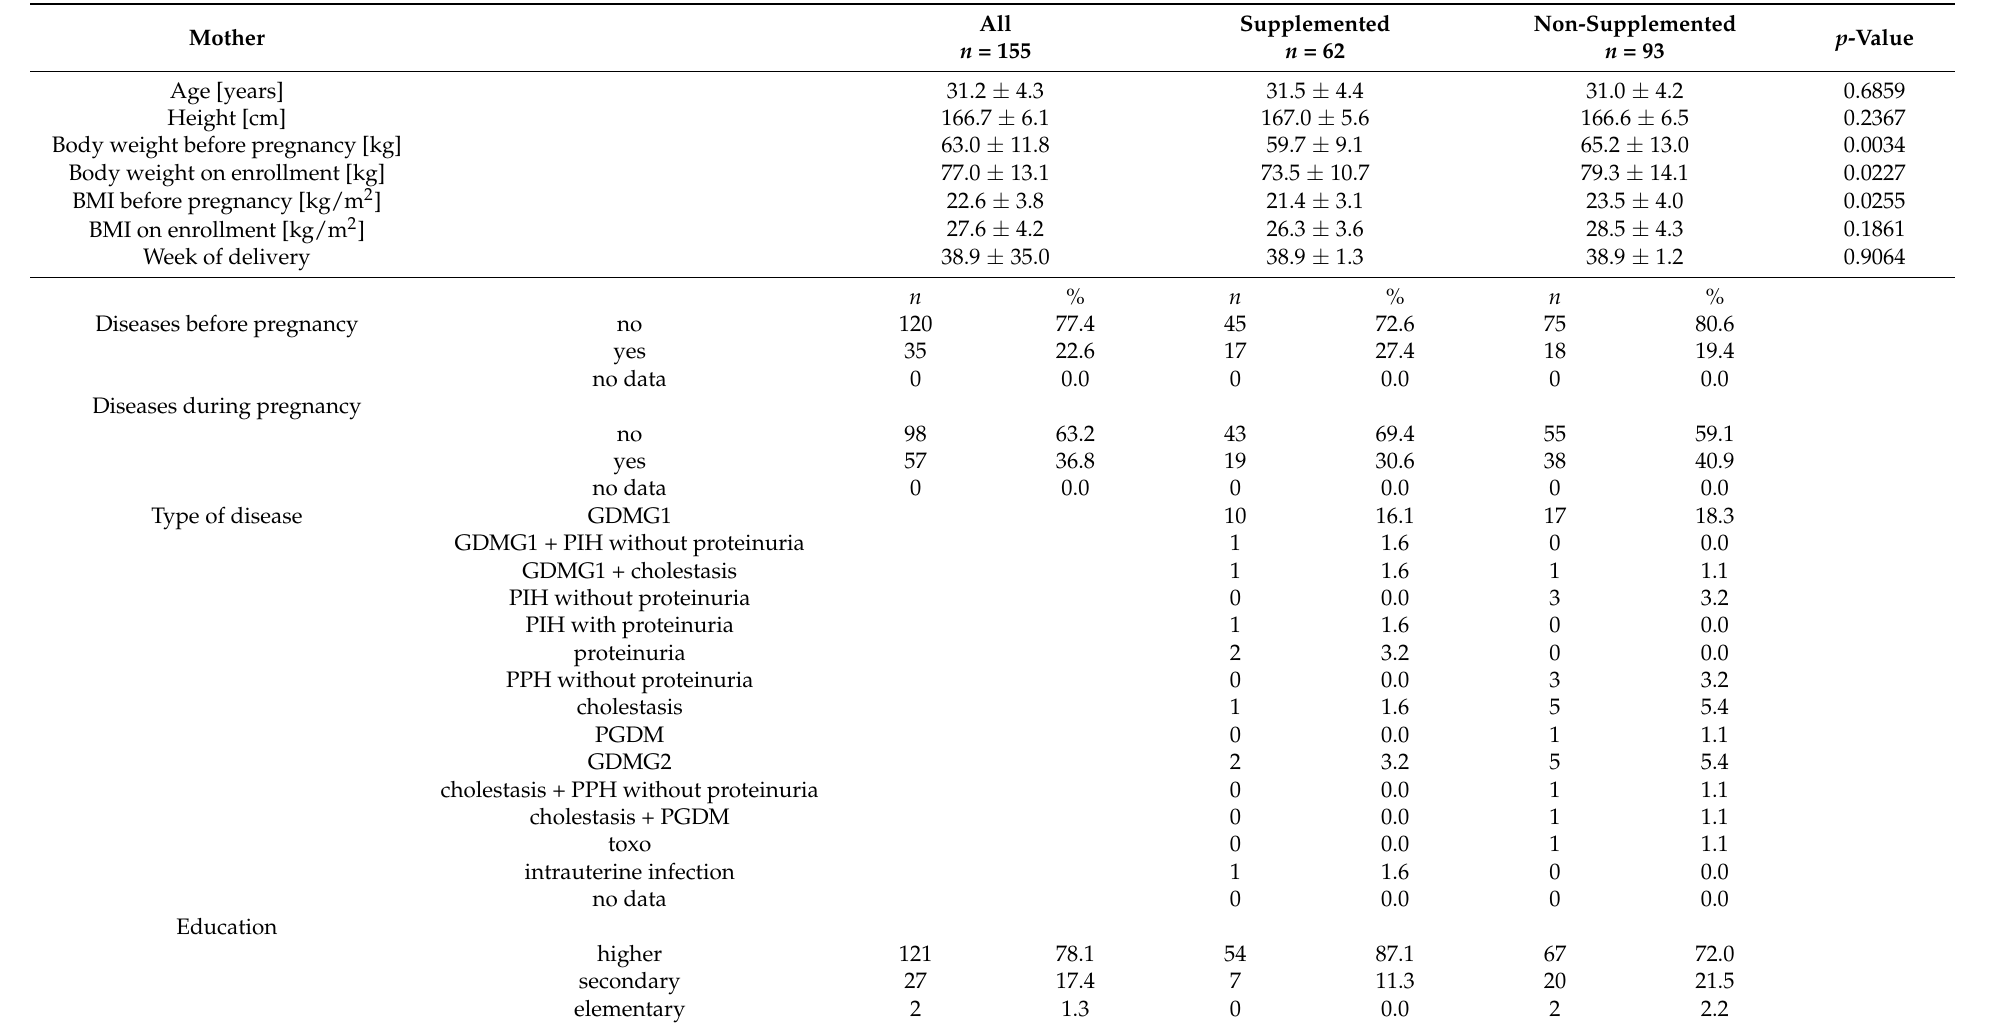
Table 1. Characteristics of the